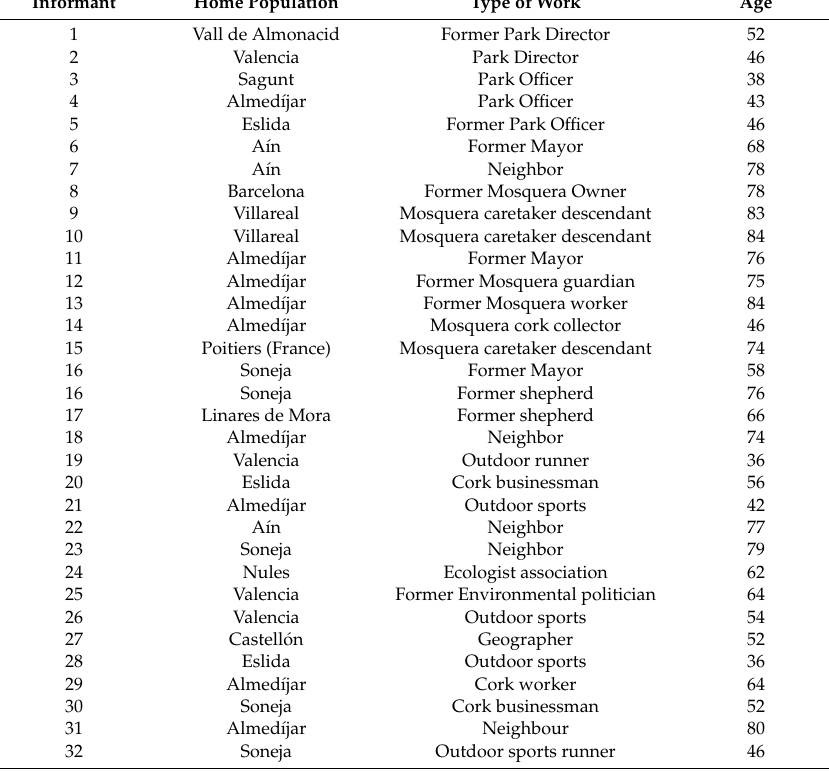
Table 2. Informant